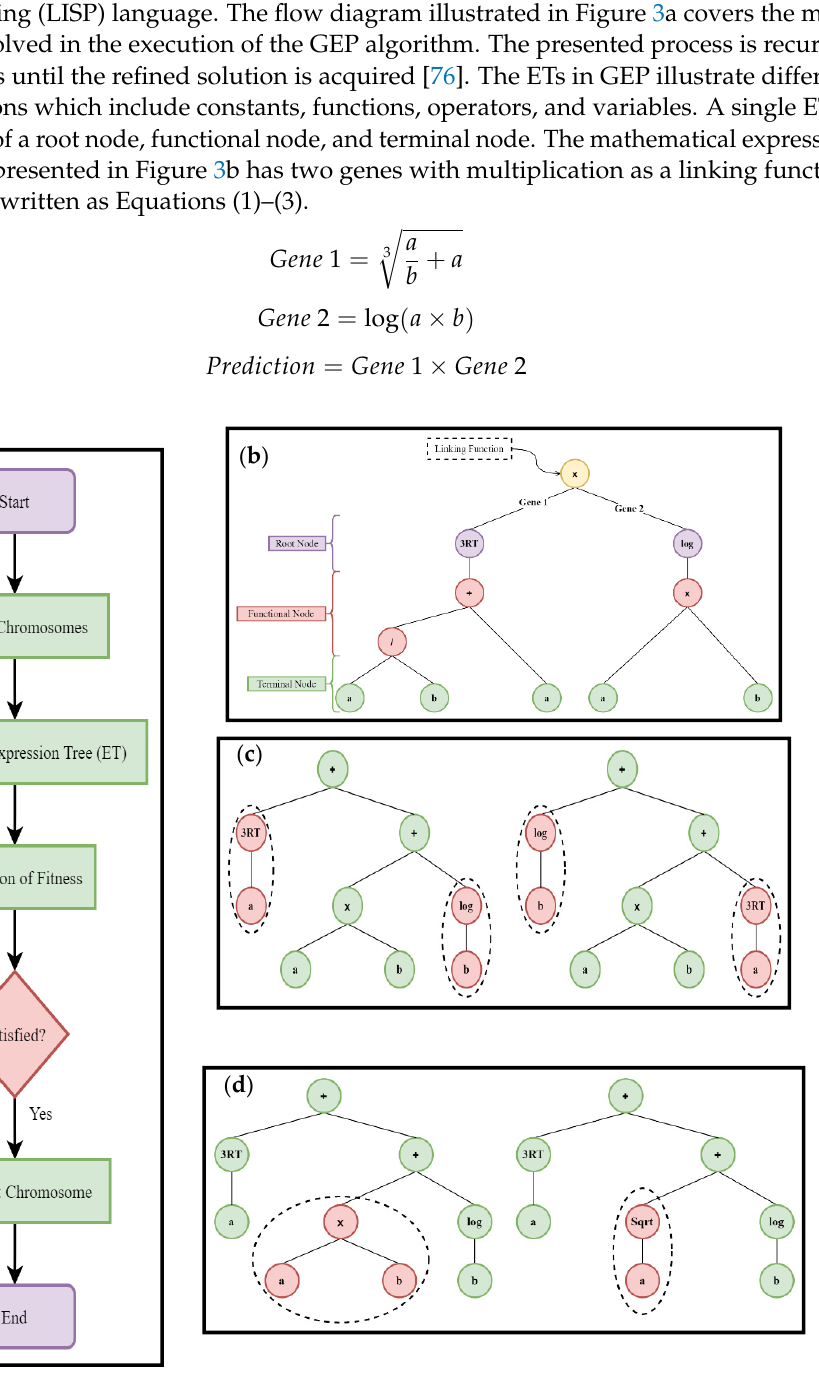
Figure 3. ( a ) Main steps involved in GEP algorithm; ( b ) Representation of typical expression tree (ET); ( c ) Process of crossover; ( d ) Process of mutation taking place in GEP.